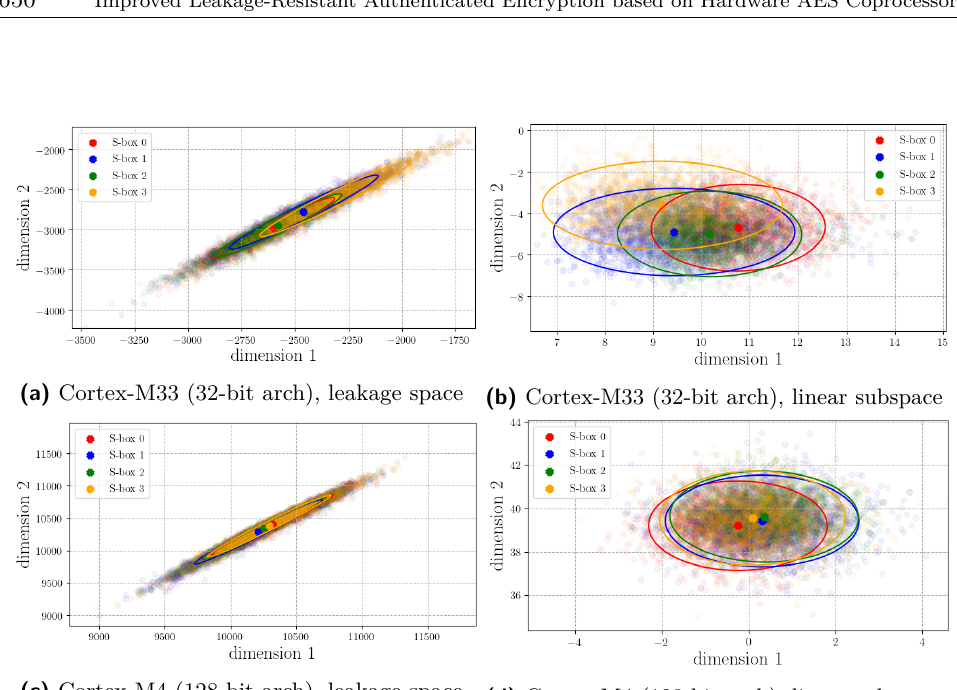
Figure 4: Leakage distributions of multiple S-boxes for a constant input value. Distribu- tions after 256 (resp., 2048) averaging on the ARM Cortex-M33 (resp., Cortex-M4). The linear subspace is the one of the first S-box. The two dimensions of the original leakage space are the ones with highest SNR. Curves represent a Gaussian fit on the clusters.